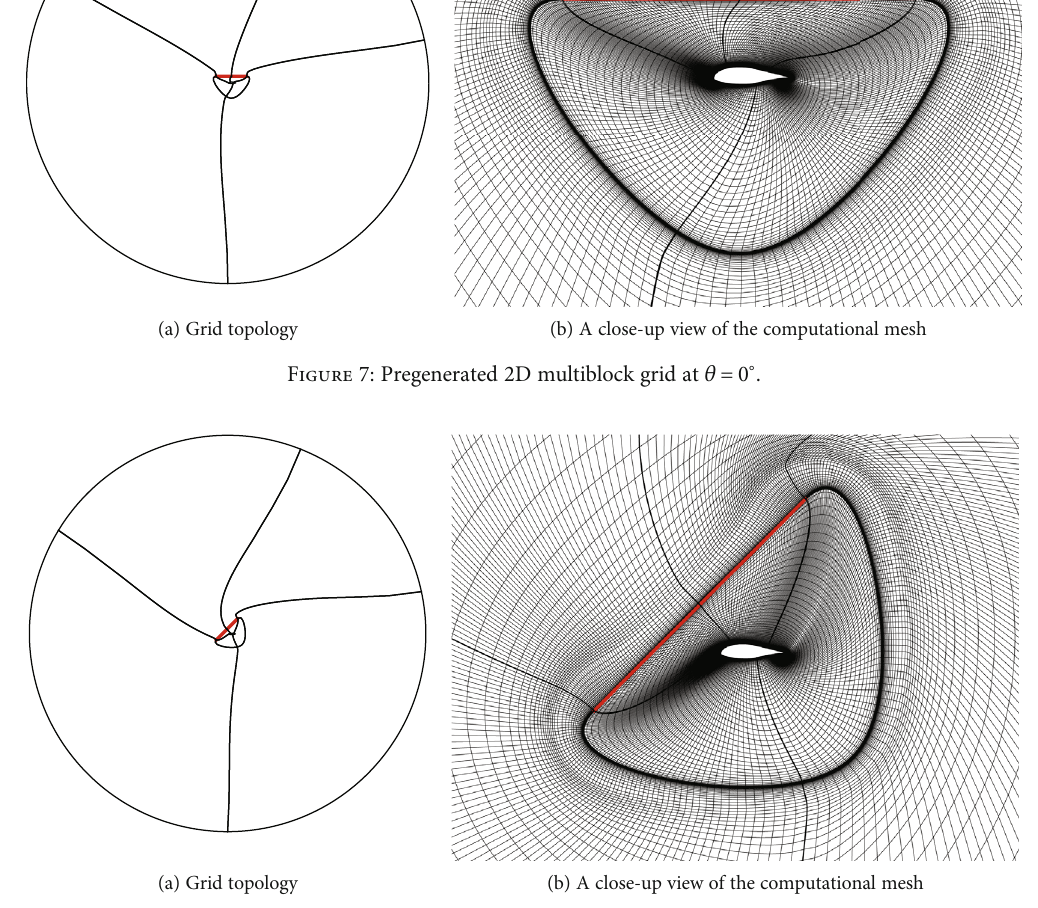
Figure 8: Pregenerated 2D multiblock grid at θ = 45 ° .